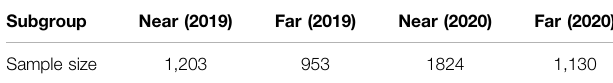
TABLE2| Thefoursubgroupsandtheirsamplesizesafterpartitioningbydistance (where near : (cid:2) within 25km of CBD), and year of sale in the period 1